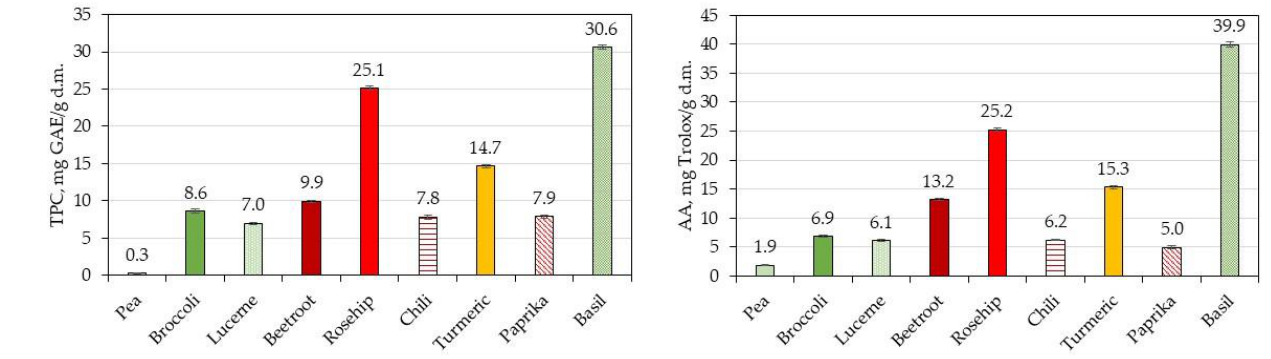
Figure 3. Total polyphenolic content (TPC) and antioxidant activity (AA) of the ingredients.